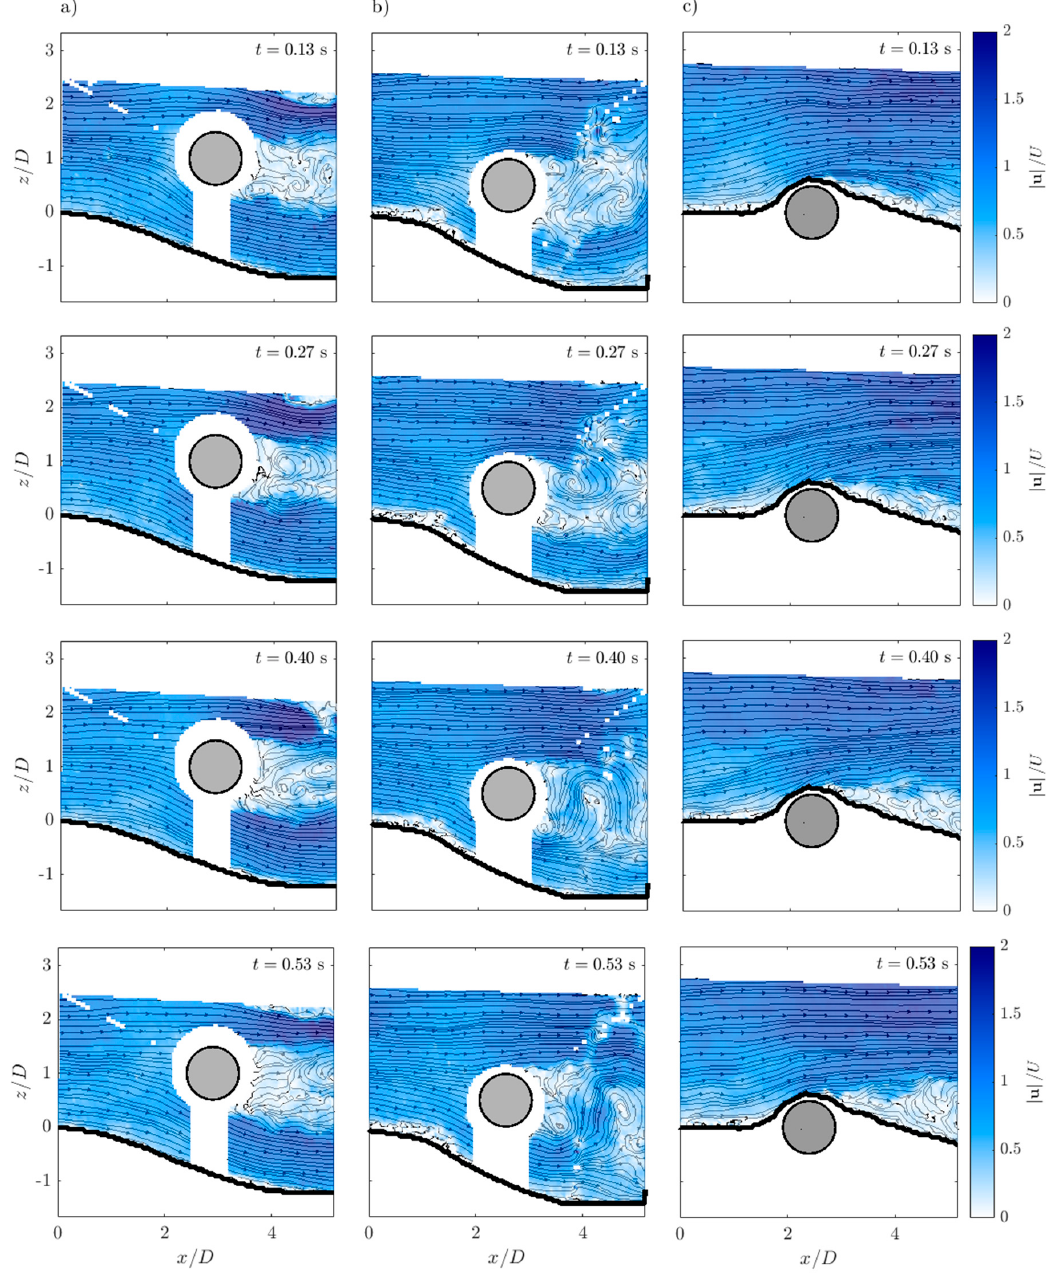
Figure 4. Dimensionless instantaneous velocity fields at different times t on a vertical plane in ( a ) Run 1, ( b ) Run 2 and ( c ) Run 3.